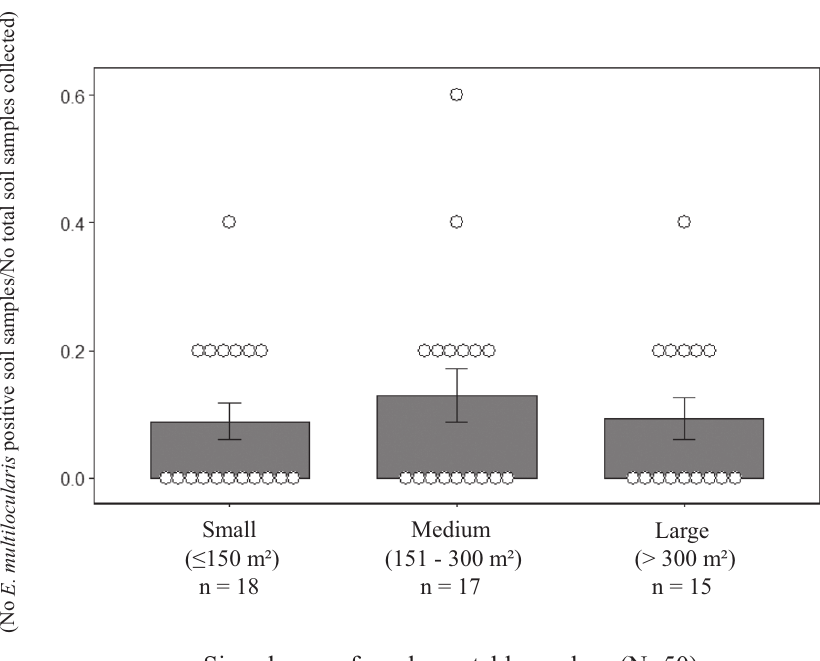
Figure 3. Index of soil contamination by Echinococcus multilocularis in relation to the size of rural vegetable gardens sampled in north- eastern France. Bars represent the mean contamination index (± Standard Error); white crenelated dots, the contamination index per vegetable garden.